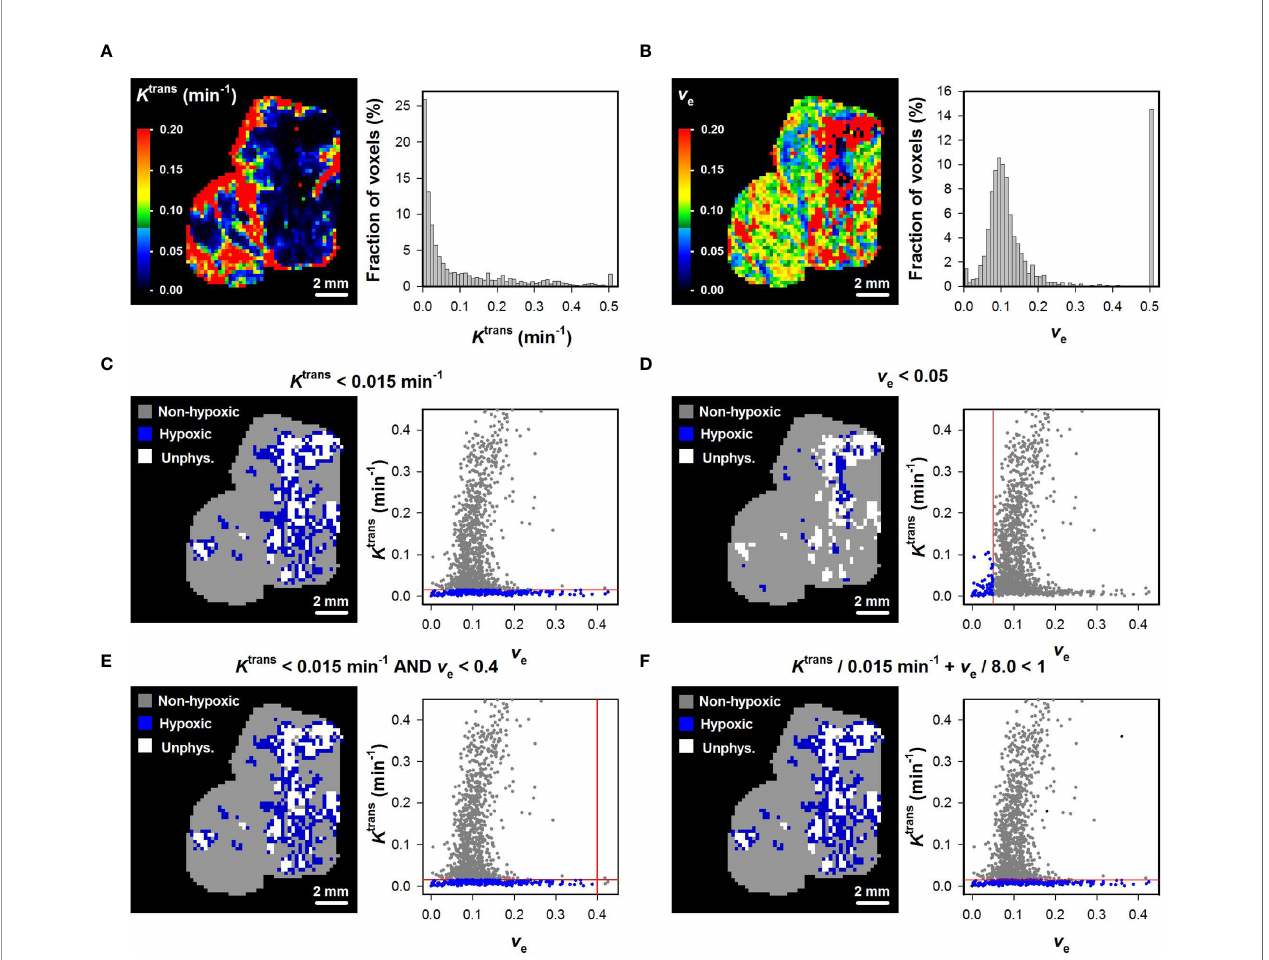
FIGURE 2 | (A, B) K trans and v e maps and histograms of a representative BK-12 cervical carcinoma xenograft. The K trans and v e scales are given by the color bars. (C – F) DCE-MRI-derived hypoxia images and plots of K trans versus v e for individual voxels of the representative BK-12 tumor. Voxels were de fi ned as hypoxic if K trans < 0.015 min -1 (C) , v e < 0.05 (D) , K trans < 0.015 min -1 and v e < 0.4 (E) , or K trans /0.015 min -1 + v e /8.0 < 1 (F) . Hypoxic voxels are shown in blue color, normoxic voxels are shown in gray color, and voxels with unphysiological v e values ( v e > 1) are shown in white color. Solid red lines indicate the threshold values used to de fi ne hypoxic